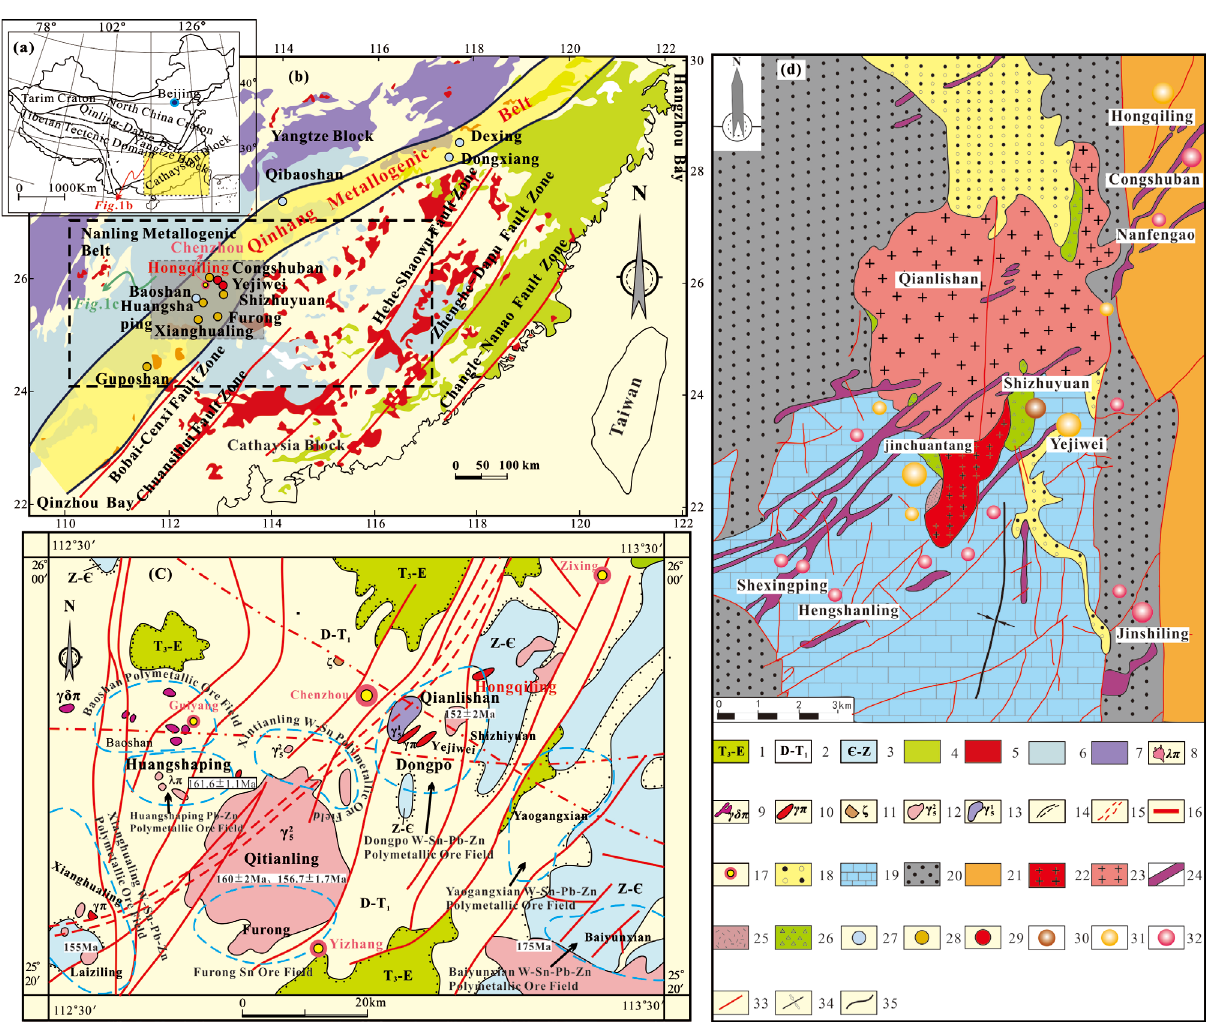
Figure 1. ( a ) Location map of the Nanling area; ( b ) distribution of granites and major W-Sn-Cu deposits in the Qinhang and Nanling metallogenic belts (after [37–39]); ( c ) geological sketch of the Qianlishan- Qitianling area (after [40]); ( d ) geological sketch of the Qianlishan granite and surrounding deposits (after [35]). 1. Upper Triassic-Paleogene System; 2. Devonian-Lower Triassic System; 3.